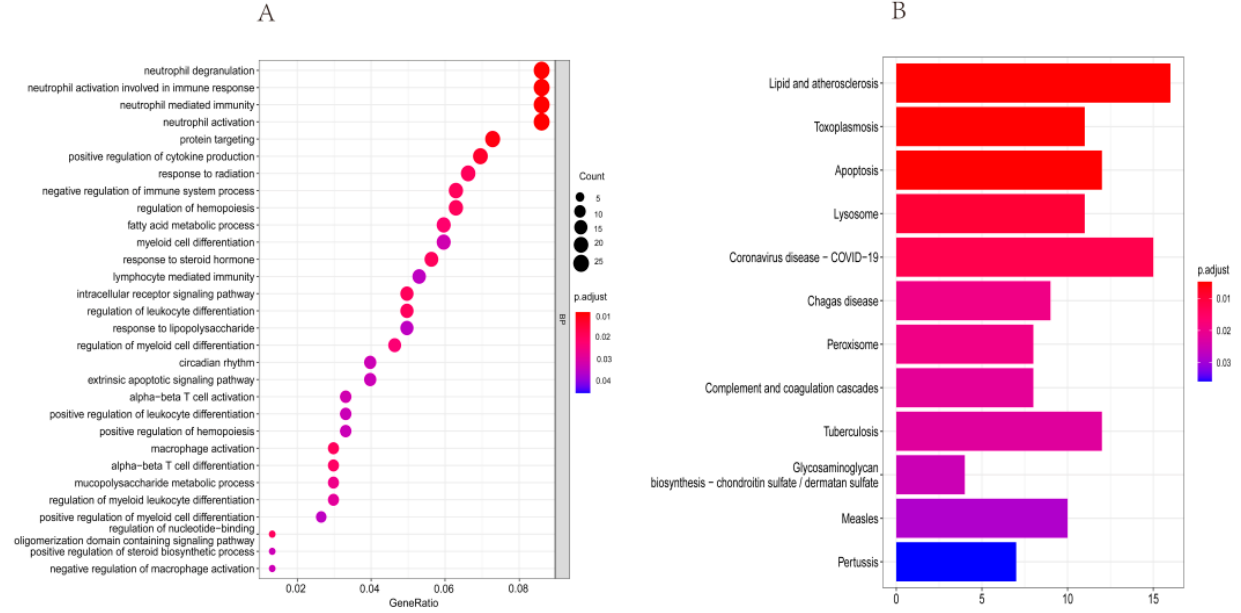
Figure 3. GO and KEGG analyses of DERGs ( p . adjust < 0.05). ( A ) Biological process enrichment analysis of DERGs; ( B ) KEGG pathway enrichment analysis of DERGs. The redder the color of the dots and columns, the greater the significance. BP: biological process.